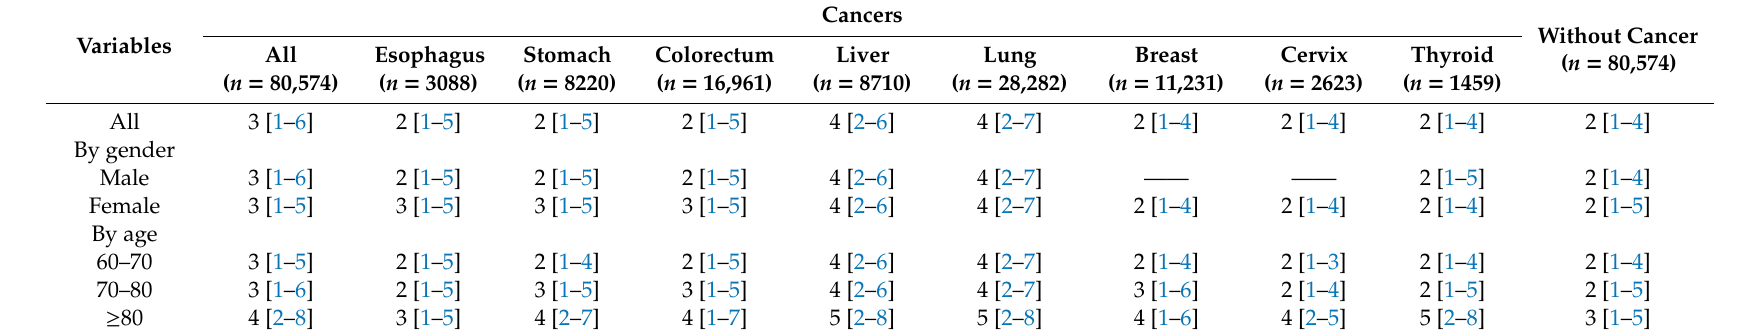
Table 1. Number of comorbidities of patients with and without cancer.